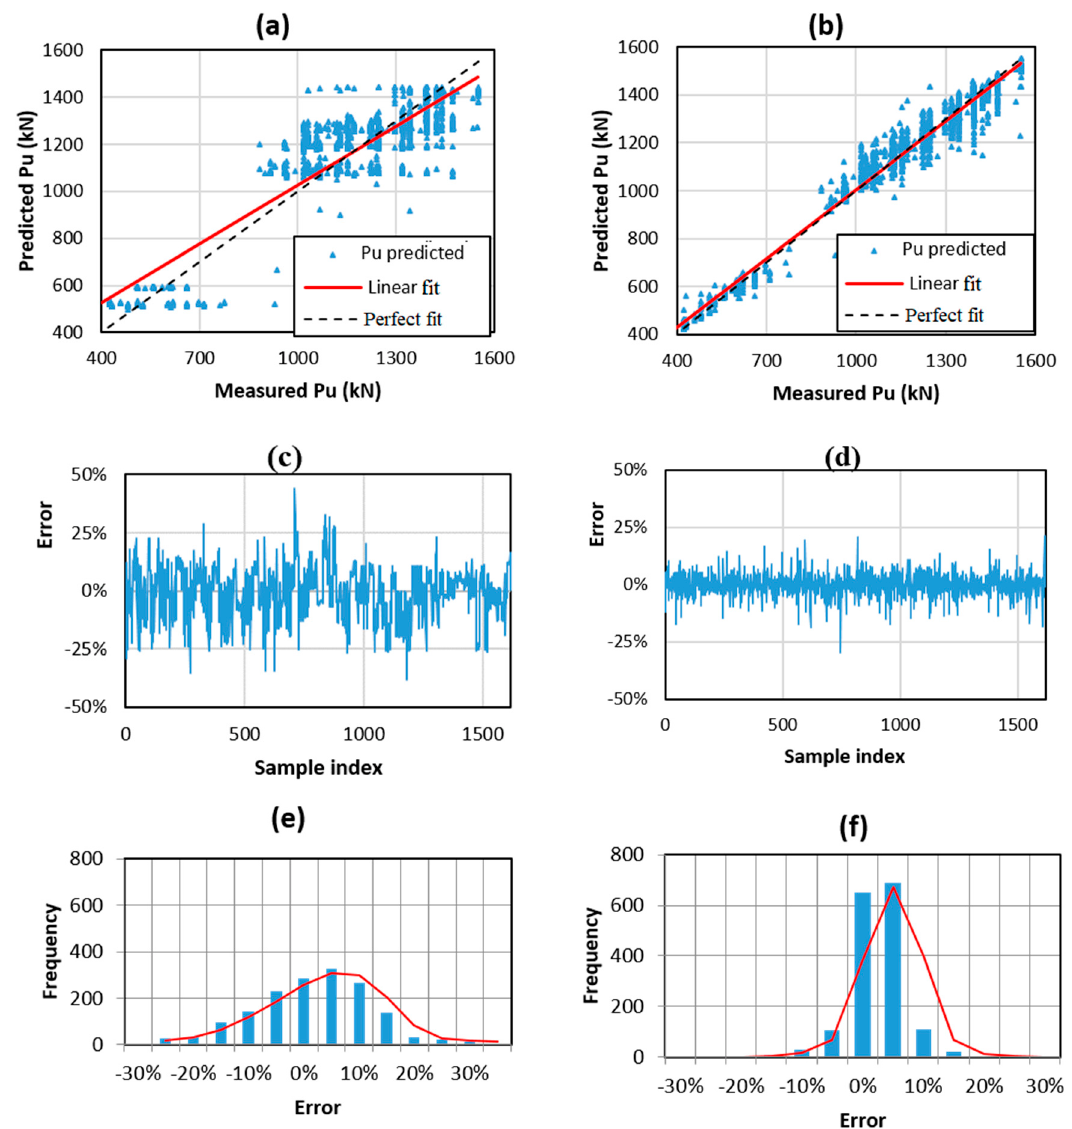
Figure 6. Graphs of regression results between measured P u versus predicted Pu for the training part using ( a ) ANN, ( b ) RF, ( c ) mean error ANN, ( d ) mean error RF, ( e ) standard deviation ANN, and ( f ) standard deviation RF.